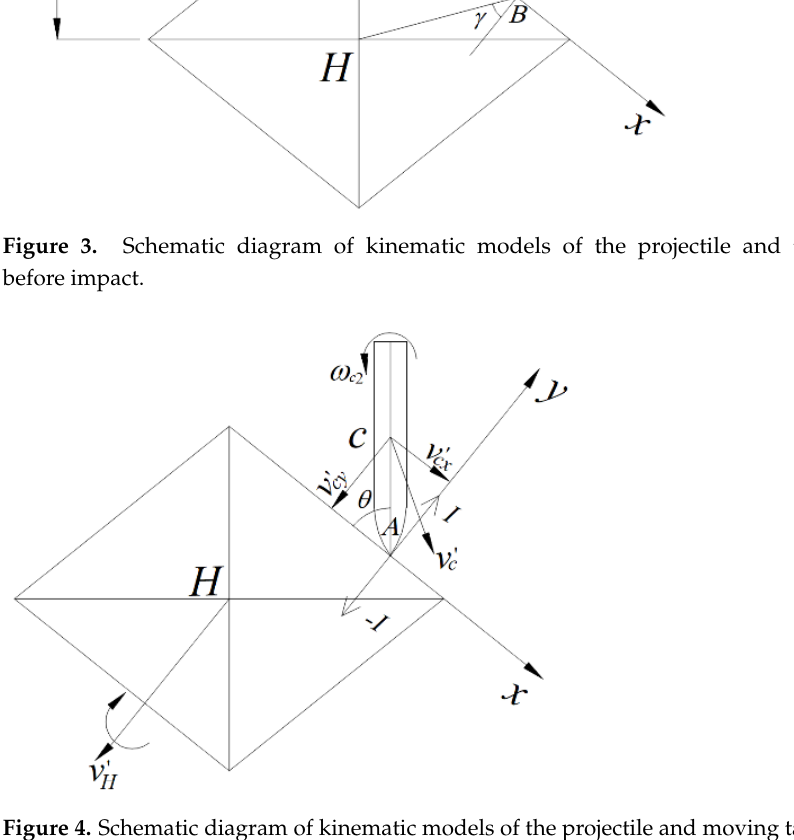
Figure 4. Schematic diagram of kinematic models of the projectile and moving target after impact.